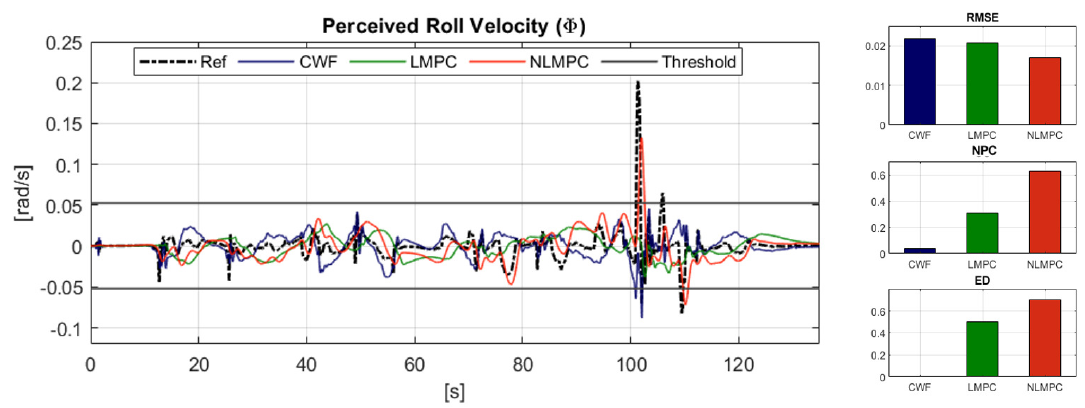
Figure 12. Reference Tracking performance: Perceived Roll Velocity.